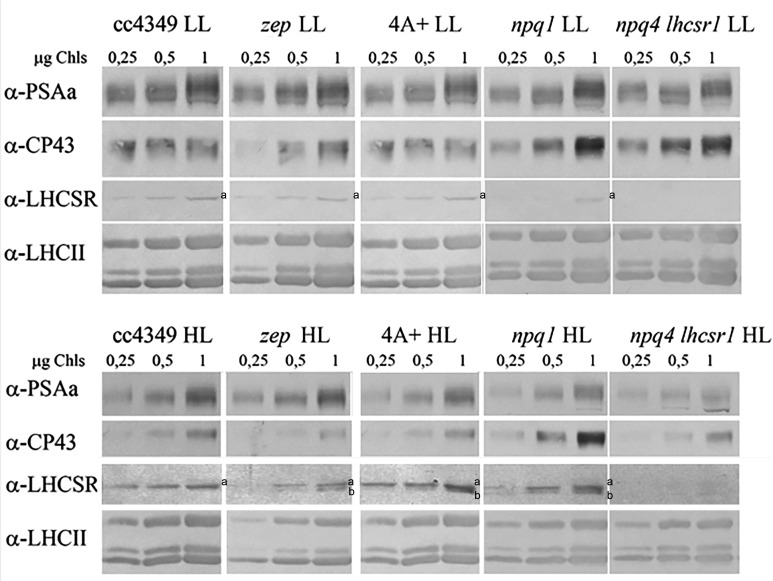
Immunoblot analysis of LHCSR accumulation in vivo.Total protein extracts from low-light (LL) or high-light (HL) acclimated cells were loaded on a chlorophyll basis (μg of chlorophylls loaded are reported in the figure). Immunoblot analysis was performed using specific antibodies recognizing PsaA, CP43, LHCSR3 (a), and LHCII subunits. The filter used for LHCSR3 detection was then used for LHCSR1 (b) detection using specific antibody. The results reported are representative of two independent experiments with different biological replicates and three technical replicates for each genotype in LL or HL.